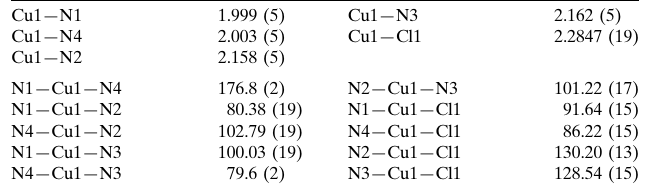
Selected geometric parameters (A˚ , (cid:1)